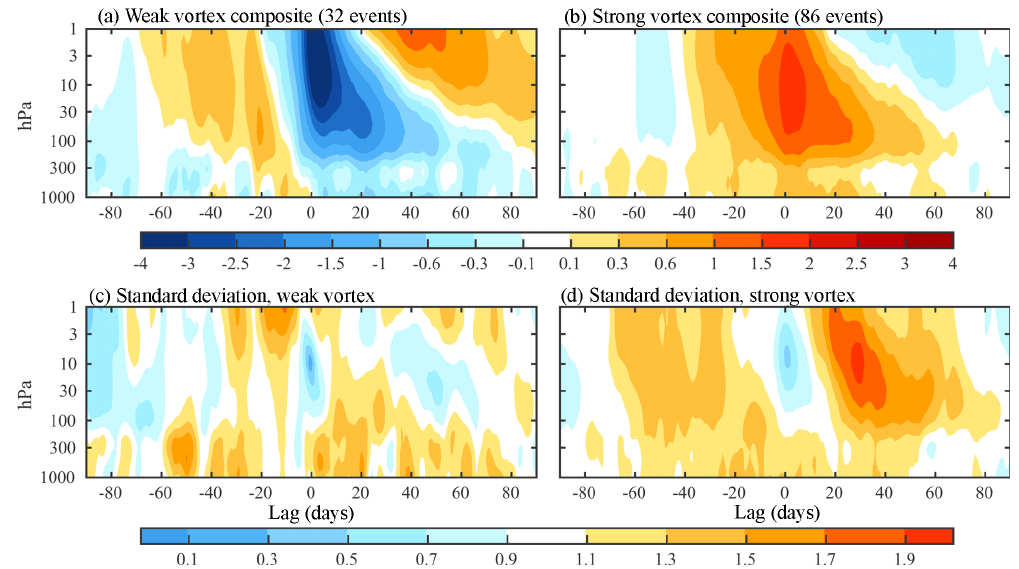
Figure 10. Composites of the Northern Annular Mode indices as a function of lag and pressure for (a) weak and (b) strong vortex events, based on JRA-55 reanalyses over the period 1958–2016. Following Baldwin and Dunkerton (2001), weak (strong) events are identified when the NAM index at 10hPa drops below − 3 (rises above 1.5) and must be separated by a minimum of 30 days. Panels (c) and (d) show the event-to-event standard deviation for weak and strong vortex events,